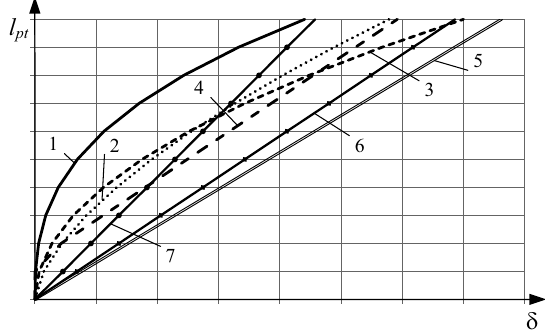
Fig. 2. Graphical dependence of pretensioned strands draw-in and transfer length: 1 – (1); 2 – (2); 3 – (3); 4 – (4); 5 – (5); 6 – (6), α = 2; 7 – (6), α =